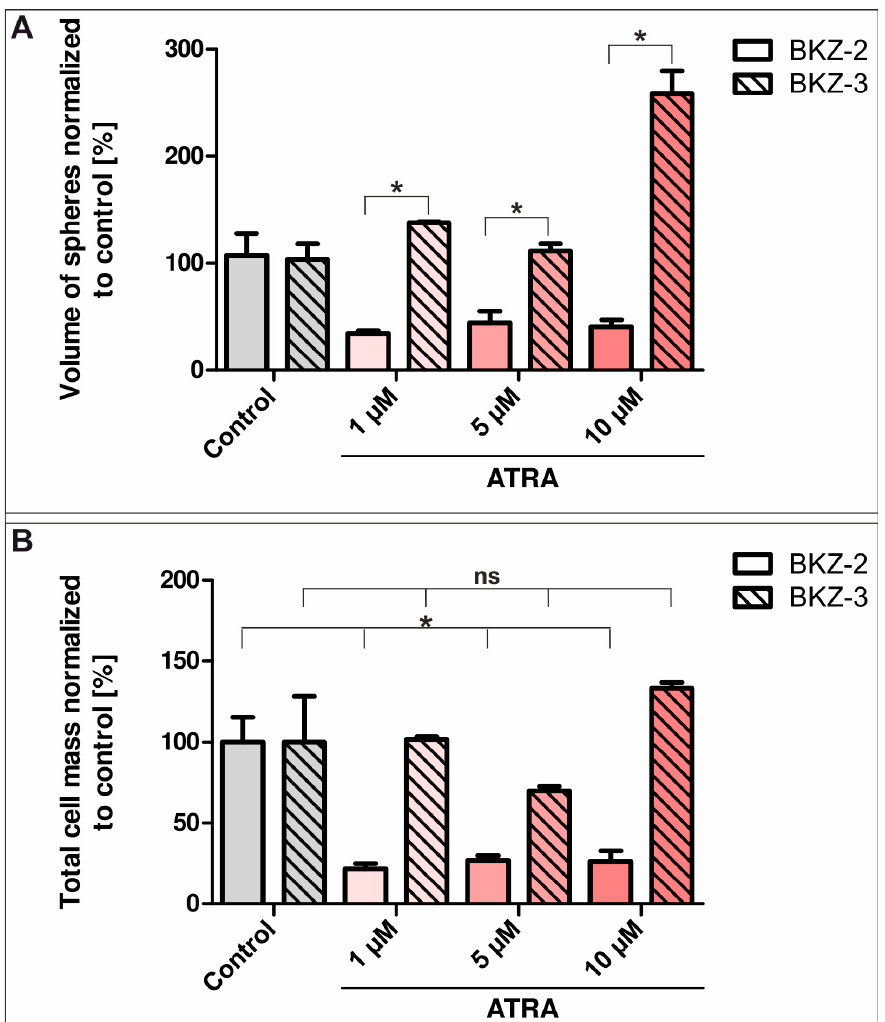
Figure 10. All-trans retinoic acid (ATRA)-treatment reduced total cell mass of BKZ-2 formed spheres, but does not have an effect on total cell mass of BKZ-3 formed spheres. Analysis of the quantification of the ( A ) volume of the spheres formed by the two colorectal cancer cell lines revealed a significant difference after ATRA-treatment. ATRA-treatment led to the formation of significant bigger spheres formed by BKZ-3 in comparison to BKZ-2. Further quantification of ( B ) the total cell mass revealed a significantly decreased cell mass for BKZ-2 upon ATRA stimulation, while the total cell mass of BKZ-3 was not altered. Non-parametric Mann-Whitney-test ( p ≤ 0.05). n = 3, * p ≤ 0.05, ns = not significant. Mean ± SEM (standard error of the mean).